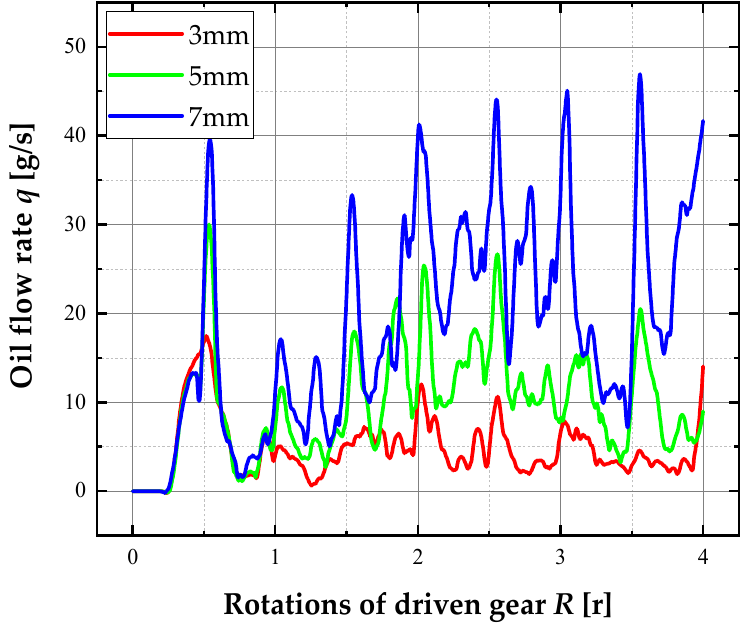
Figure 9. Oil flow rate of the meshing area at various inner diameters of the oil-guiding tube.